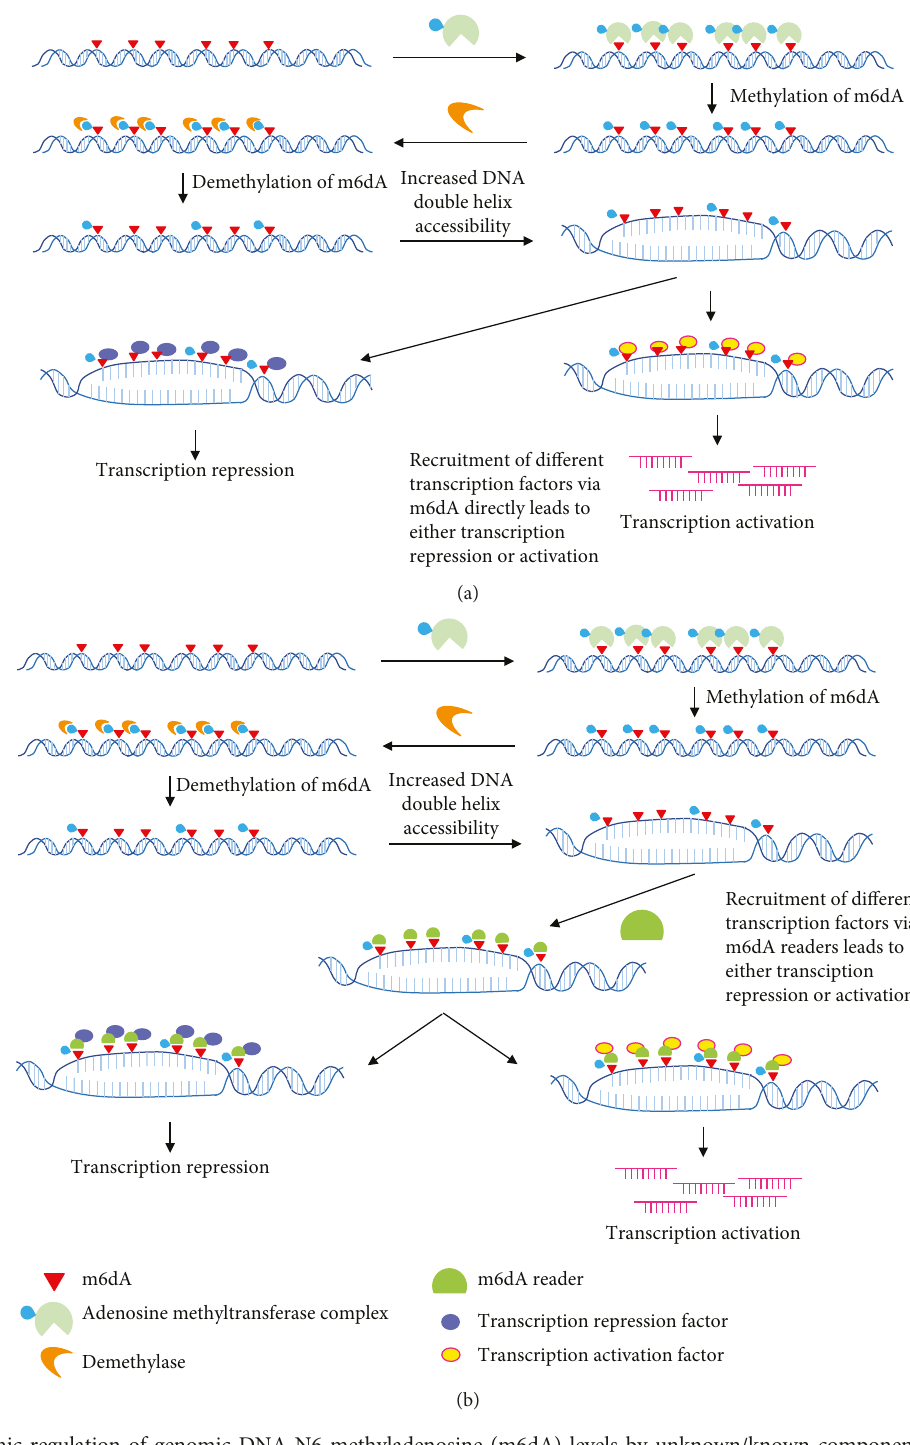
Figure 1: Dynamic regulation of genomic DNA N6-methyladenosine (m6dA) levels by unknown/known components and the potential functions of m6dA in the regulation of gene expression. The coordination between m6dA writer(s) and m6dA erasers maintains the m6dA levels in accordance with physiological conditions and the development and growth stages. (a) The hypothesis for m6dA-mediated regulation of gene expression is that by decreasing the binding energies of base pairs, m6dA could destabilize the DNA duplexes, facilitating m6dA-enriched regions of DNA, unwinding, or making the DNA structure more open for transcription initiation. The m6dA readers (to be identi fi ed) are highly a ffi nitive to and bind to the m6dA sites, then the readers may recruit their interaction factors involved in transcription initiation, repression, and so on. (b) Alternatively, it is possible though that these transcription factors might serve as reader(s) of m6dA, directly functioning as regulators of gene